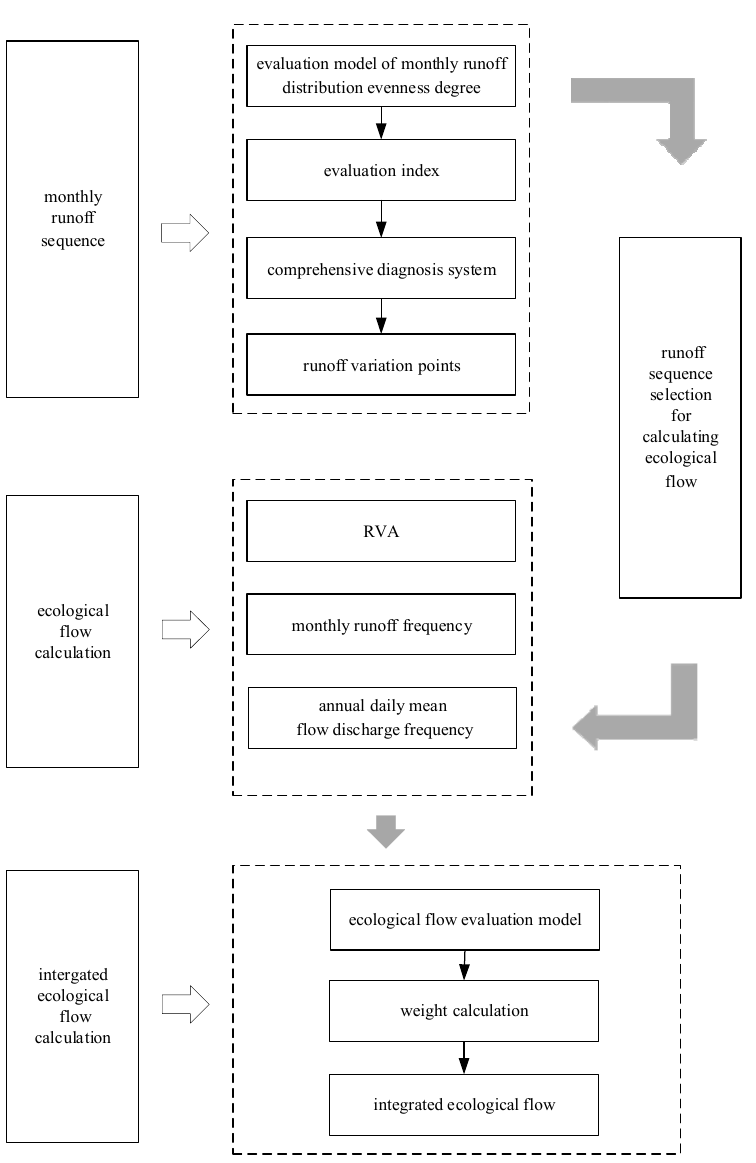
Figure 2. Flow chart of the study process. Note: RVA is the range of variability approach method.